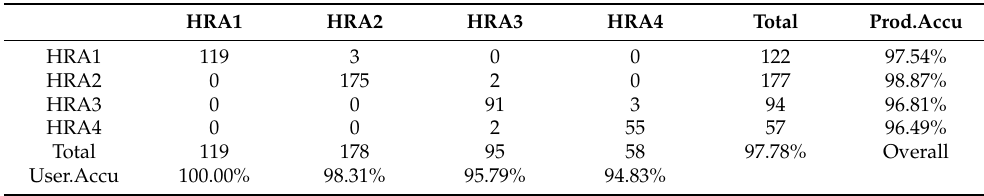
Table 2. Confusion matrix of the validation dataset in “Sierra de Álvarez.” Prod.Accu = Producer Accuracy and User.Accu = User Accuracy.